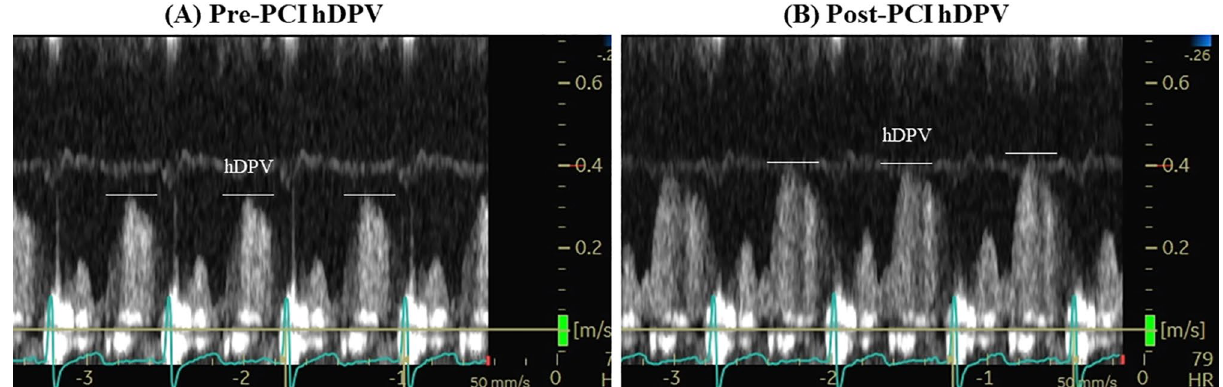
Figure 1. Representative images of coronary flow velocity measurements by transthoracic Doppler echocardiography. A representative case of a LAD lesion that underwent TDE examinations before and after successful PCI. ( A ) Pre-PCI hDPV, ( B ) post-PCI hDPV. LAD left anterior descending artery, TDE transthoracic Doppler echocardiography, PCI percutaneous coronary flow intervention, hDPV hyperaemic diastolic peak